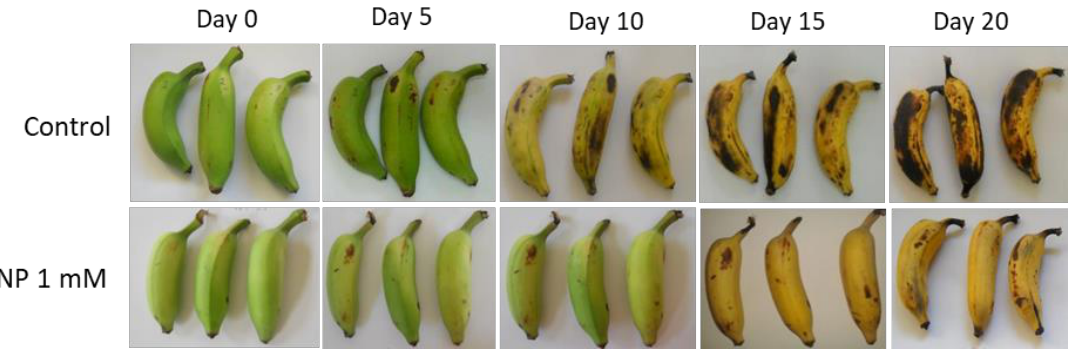
Figure 3. Representative images of banana fruit phenotypes in control and in response to sodium nitroprusside treatment.